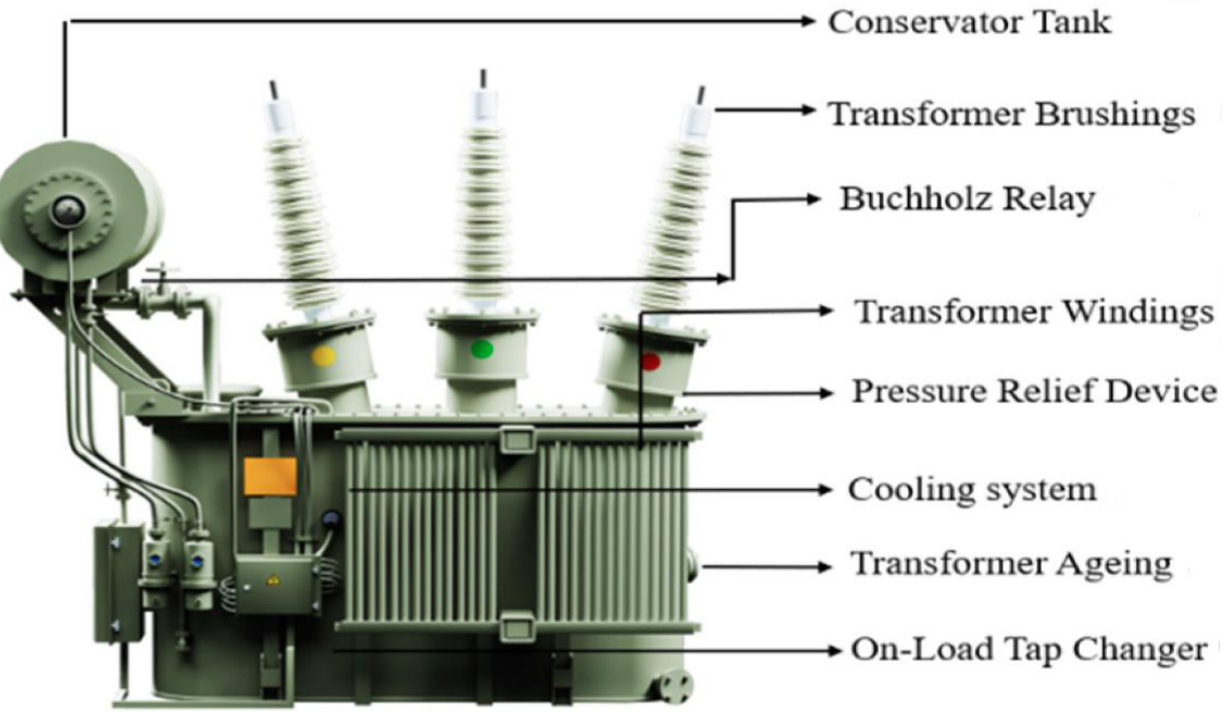
Figure 2. A typical power distribution